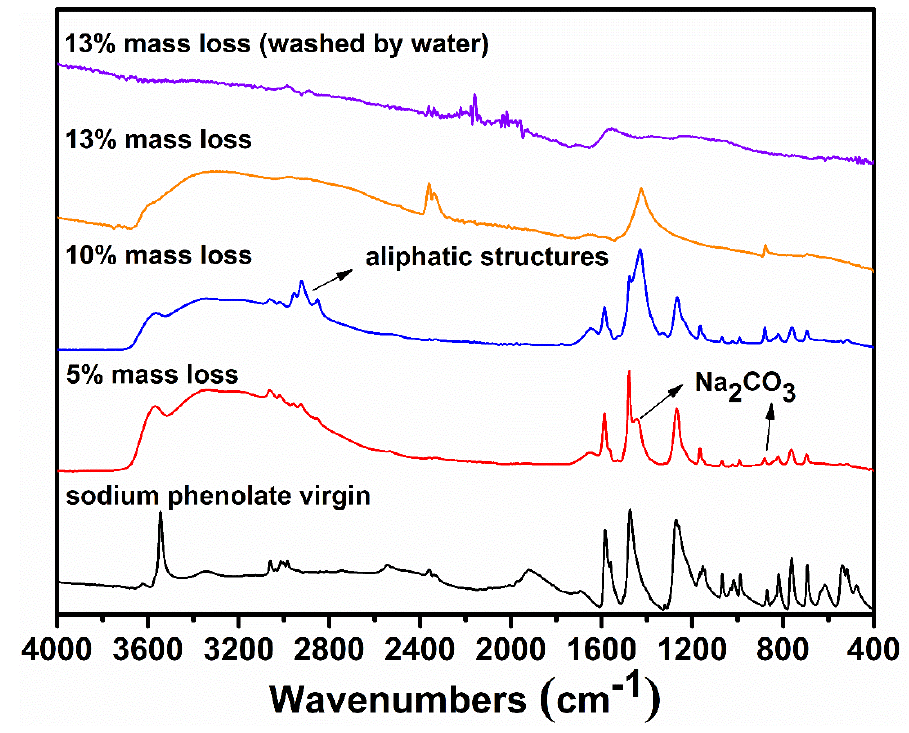
Figure 4. FTIR spectra of the residues of sodium phenolate at selected mass losses.